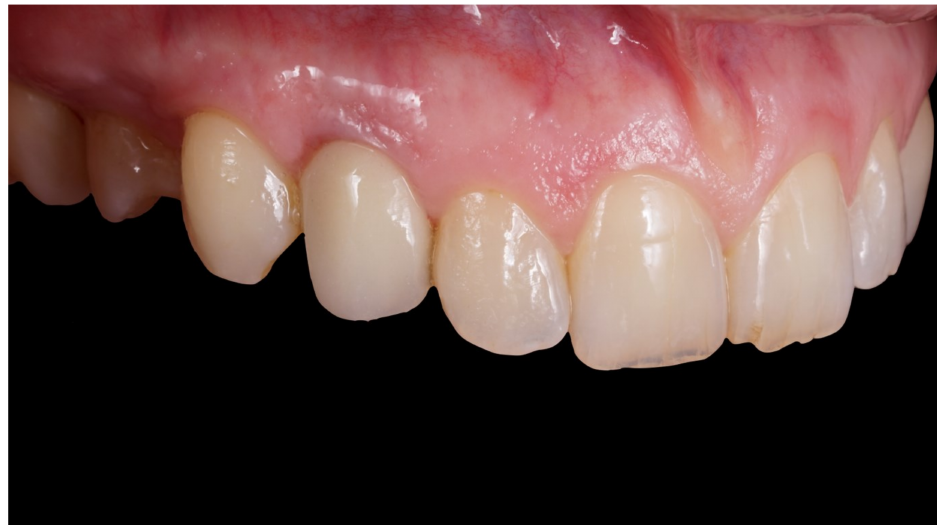
Figure 6. Healing of soft tissues around the temporary